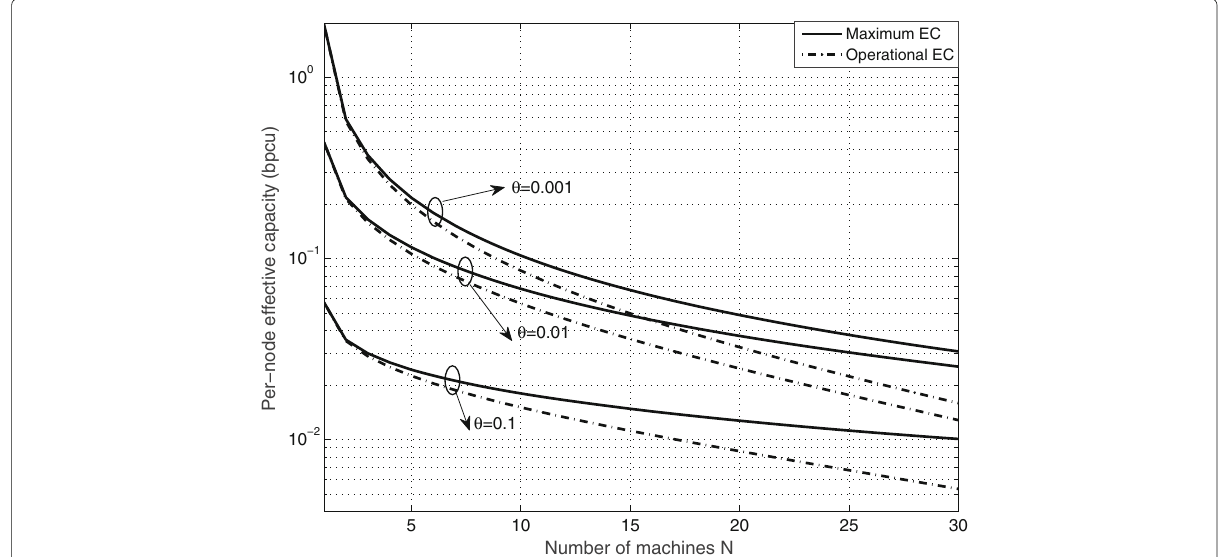
Fig. 3 Effective capacity in the ultra-reliable region. Operational and maximum effective capacity as a function of the number of machines N for T f = 1000 and ρ =